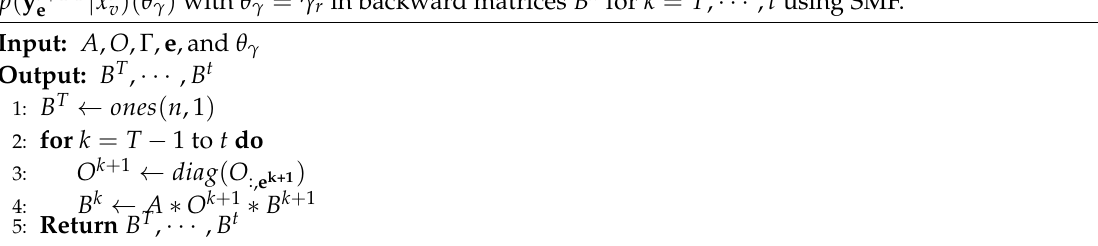
Algorithm 5 This computes the coefficients of the backward probability sensitivity